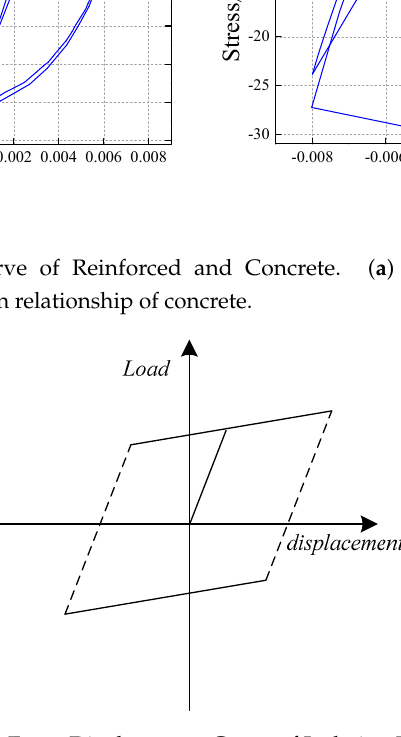
Figure 5. Force-Displacement Curve of Isolating Bearings.